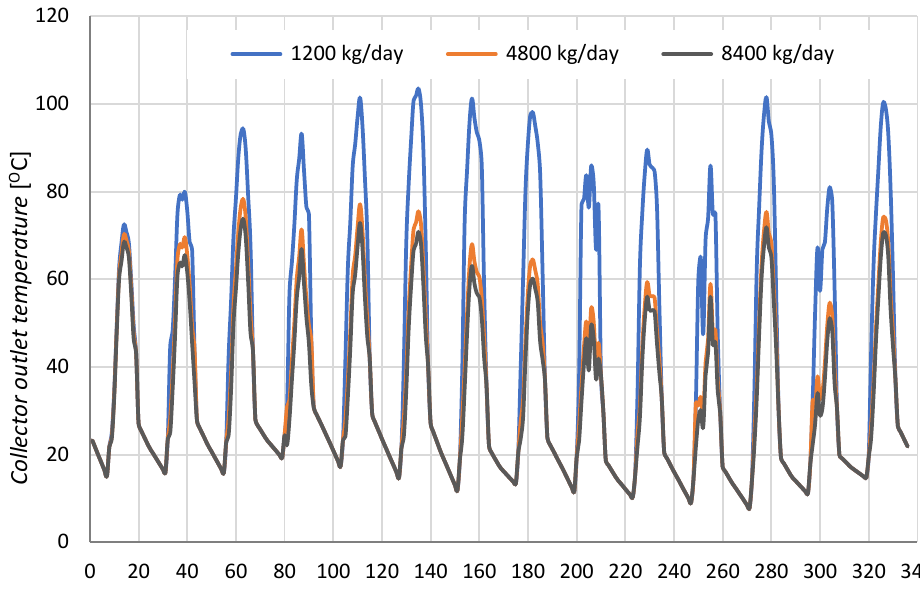
Figure 13. Outlet temperature from the solar collectors depending on the DHW consumption.